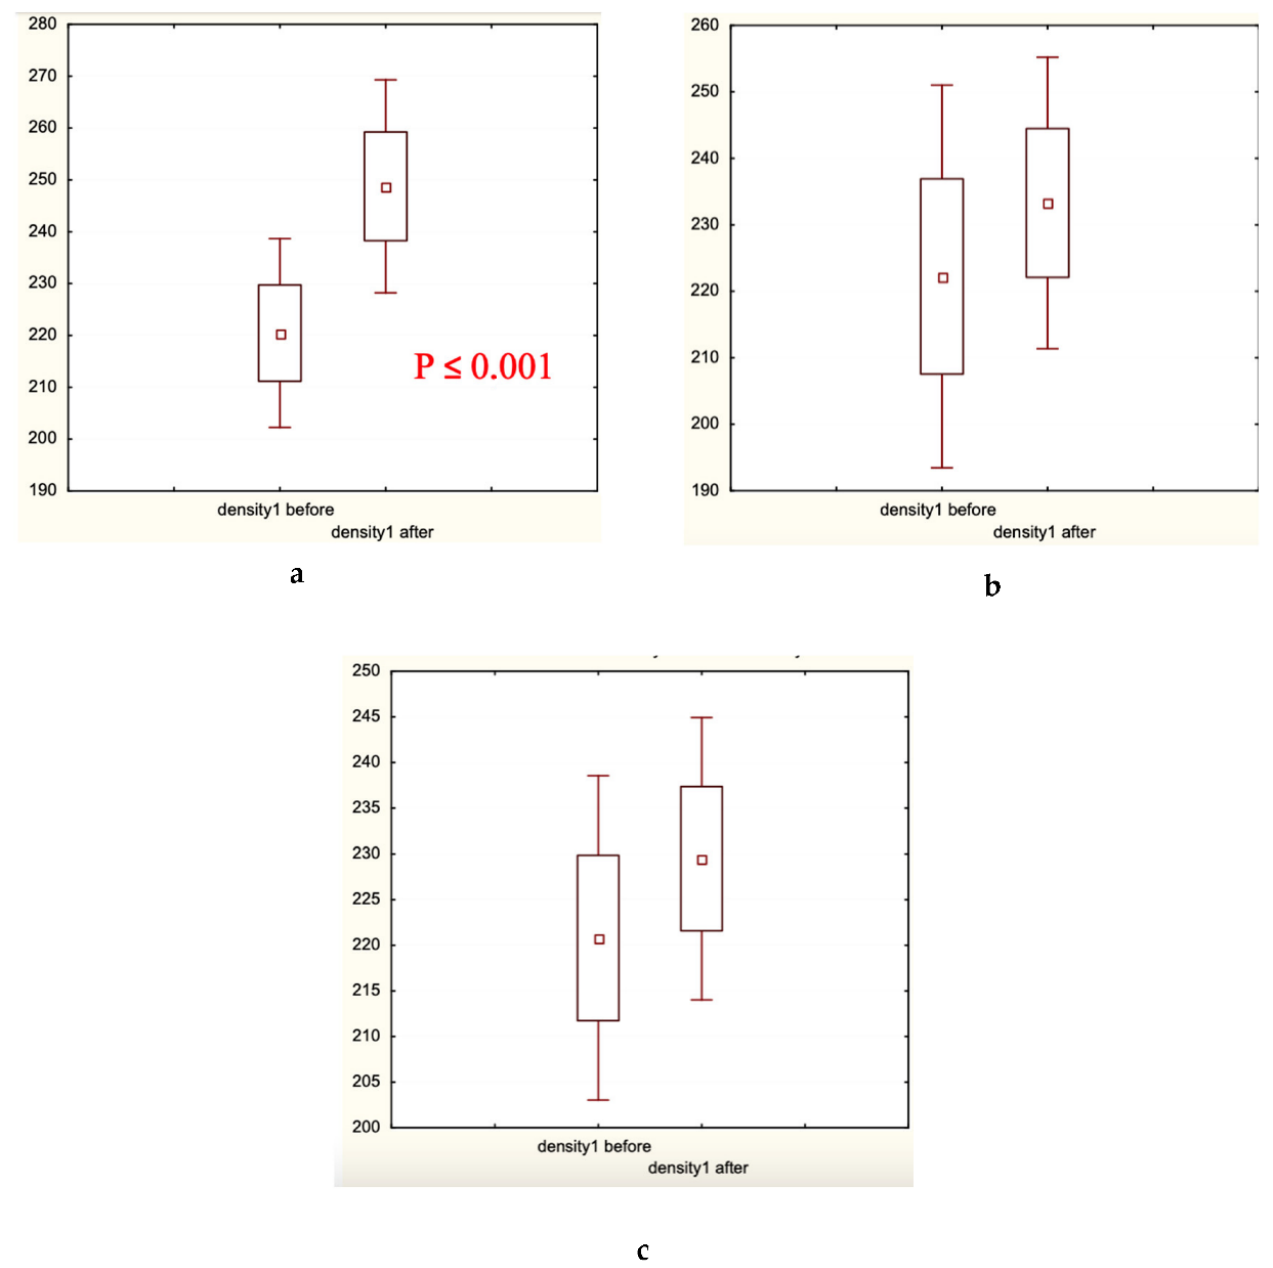
Figure 6. Hair density ( n /cm 2 ) distribution before and after the trial: ( a ) Experimental Group 1; ( b ) Placebo Control Group 2; ( c ) Caffeine Control Group 3. Small boxes—median values; large boxes—median values ± standard error of median (SEM); whiskers—median values ± 1.96 SEM. p < 0.001.